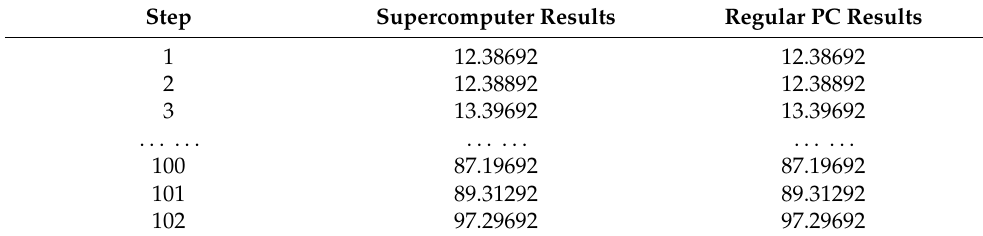
Table 4. Mathematical modeling